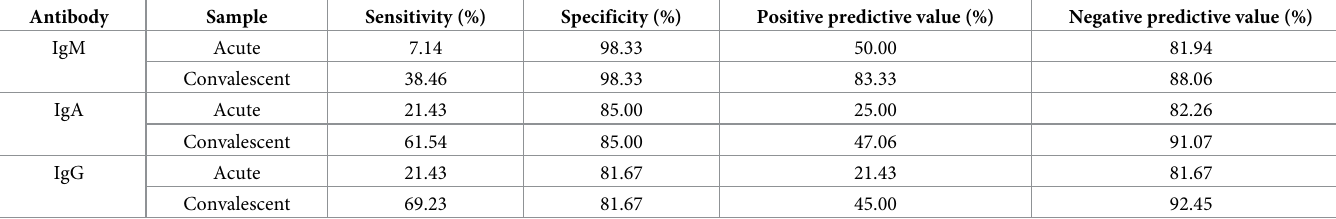
Table 2. Sensitivity, specificity, positive predictive value and negative predictive value of RBD-specific antibody detection by ELISA test. Antibody Sample Sensitivity (%) Specificity (%) Positive predictive value (%) IgM Acute